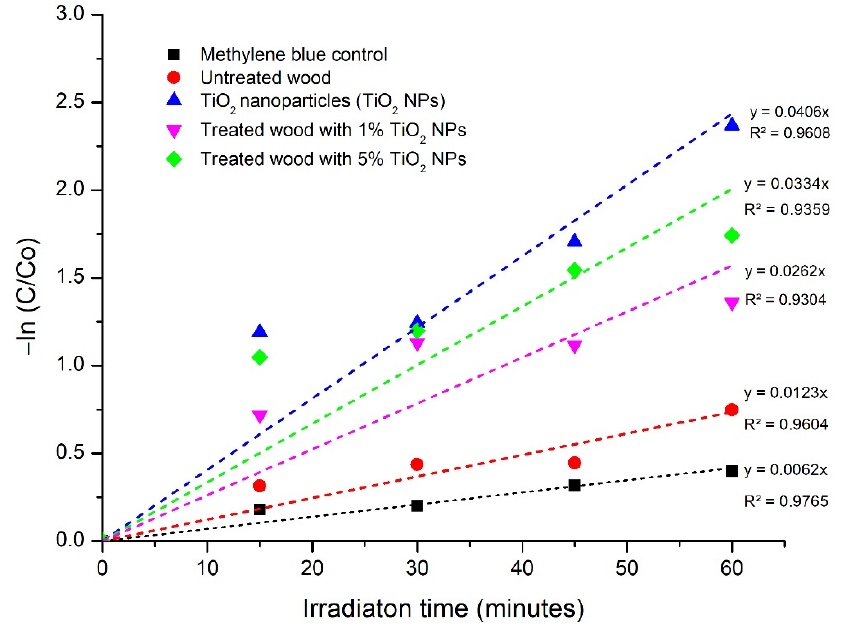
Figure 10. Reaction kinetics profile for the degradation of methylene blue in the presence of anatase TiO 2 nanoparticle. Experimental conditions photocatalyst dose = 1 g/L; methylene blue = 10 ppm.